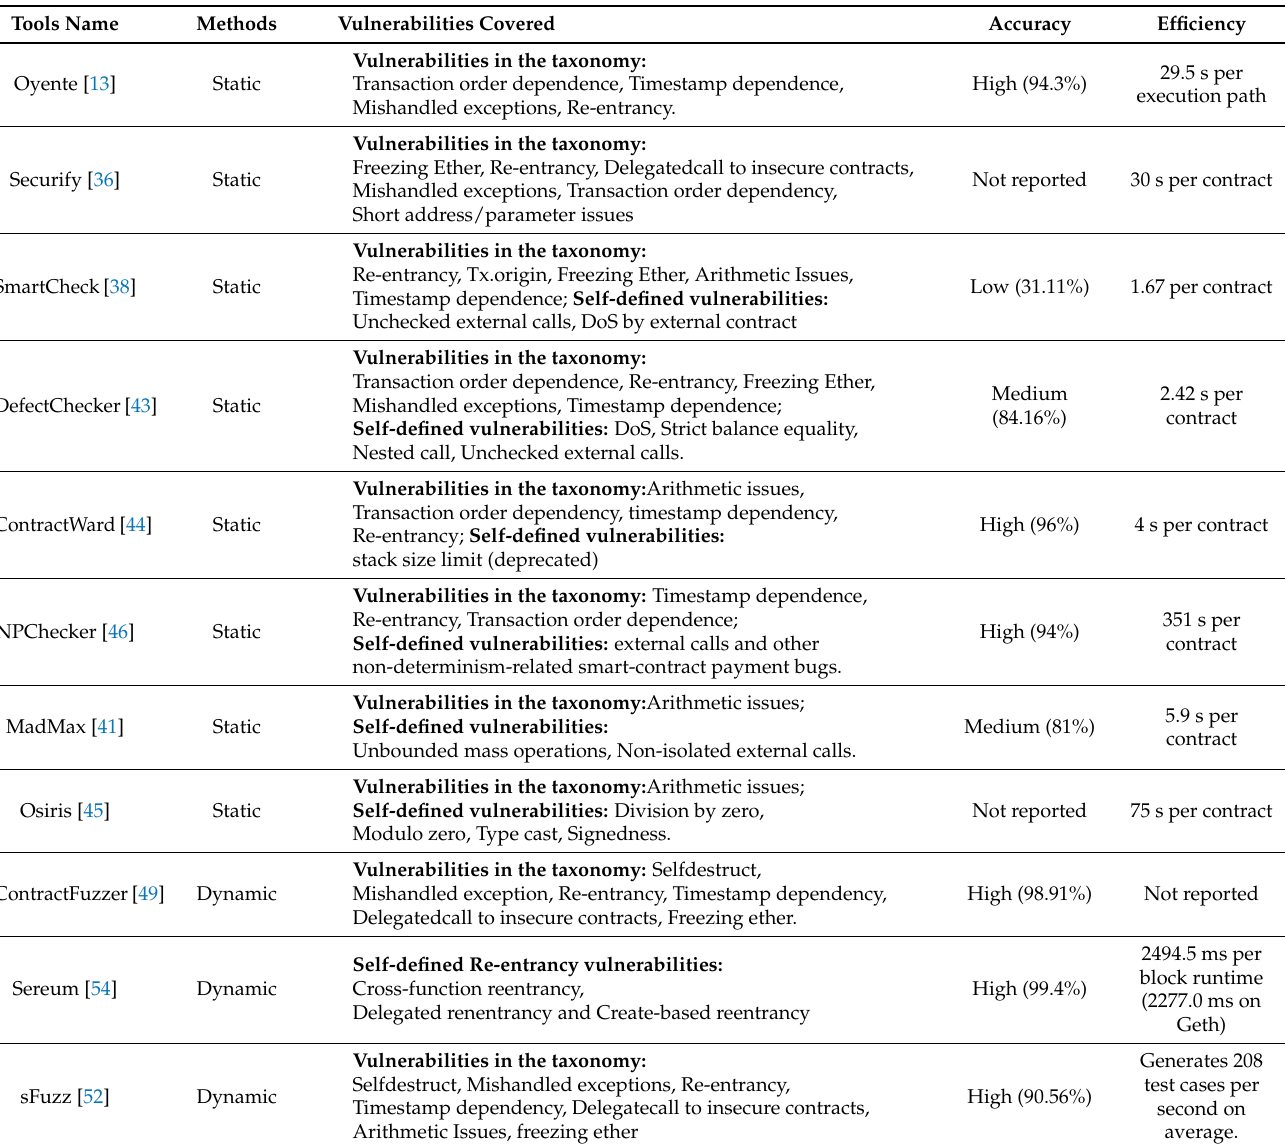
Table 4. A comparison of security-analysis tools. The first two rows were studied before 2018 by Dika in [11]. Note that the accuracy and efficiency of these tools are not really comparable as they rely on self-defined metrics by their authors. We consider reported accuracy above 90% as high, below 50% as low, and the rest as